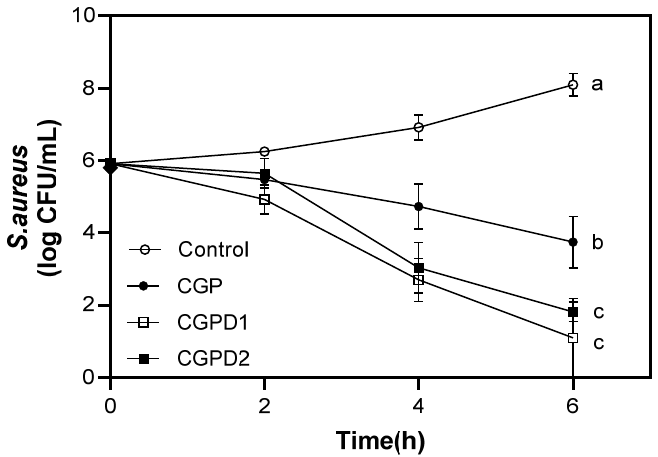
Figure 3. Antimicrobial property of films against S. aureus . The different letters indicate significant difference ( p < 0.05). Each sample was analyzed in